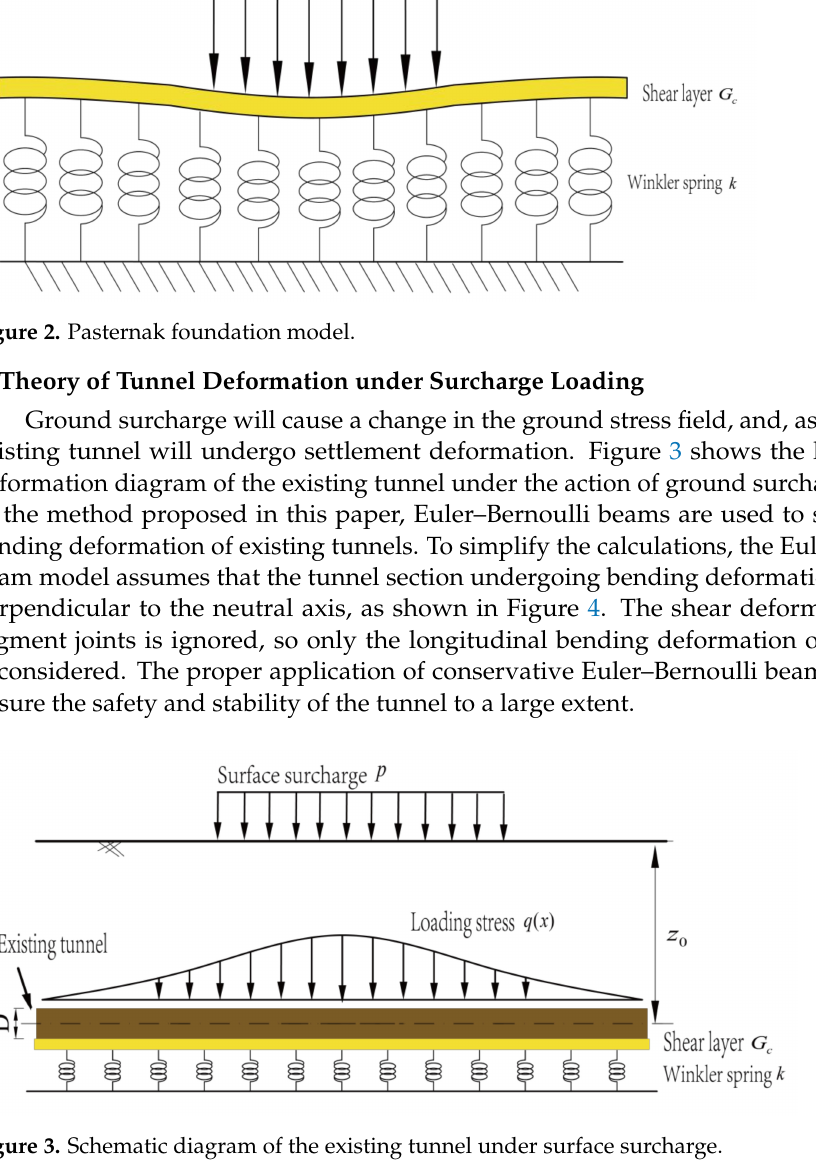
Figure 3. Schematic diagram of the existing tunnel under surface surcharge.